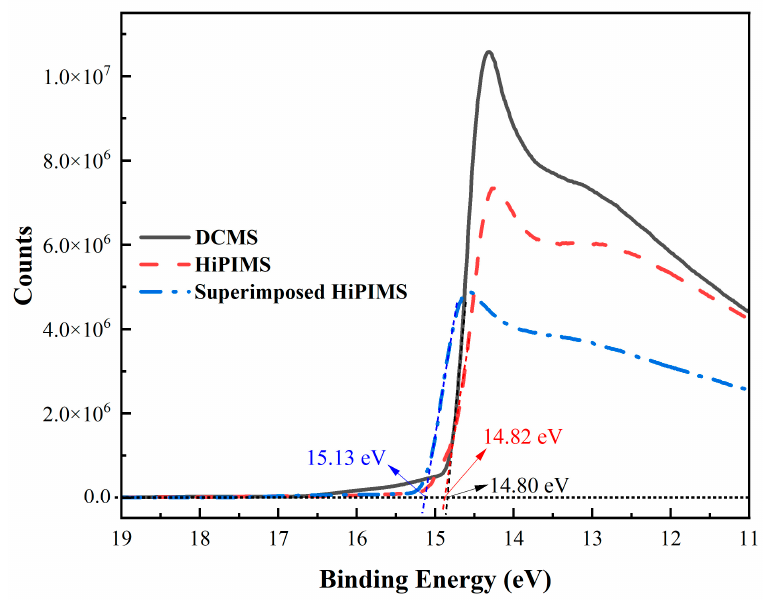
Figure 5. UPS spectra of ITO/Cu 2 O films (DCMS, HiPIMS, and superimposed HiPIMS).